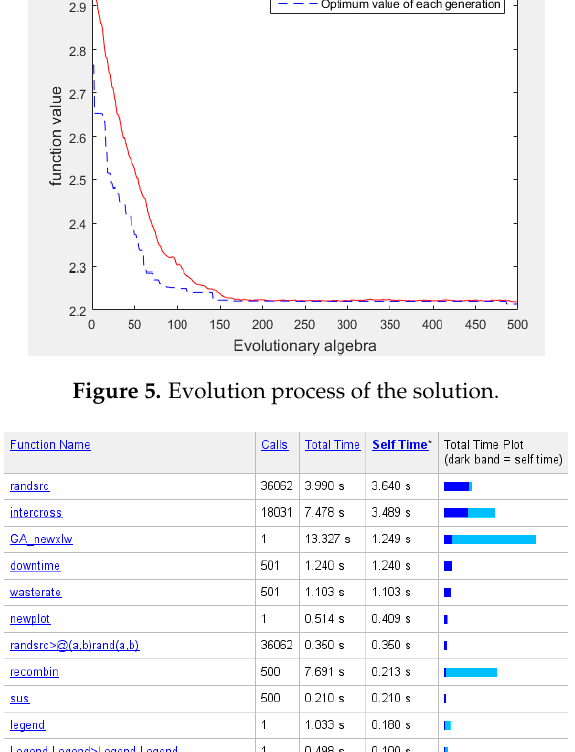
Figure 5. Evolution process of the solution.